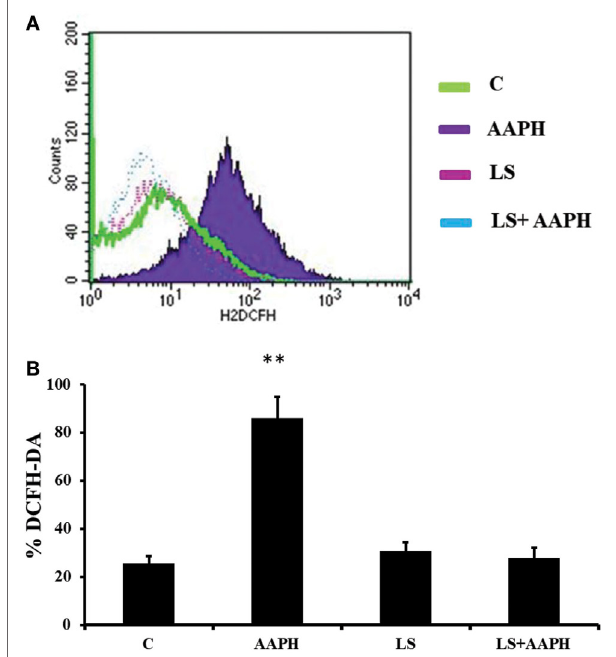
FigUre 4 | Human colon carcinoma cell line (Caco-2)/TC7 redox status. The accumulation of intracellular reactive oxygen species (ROS) was